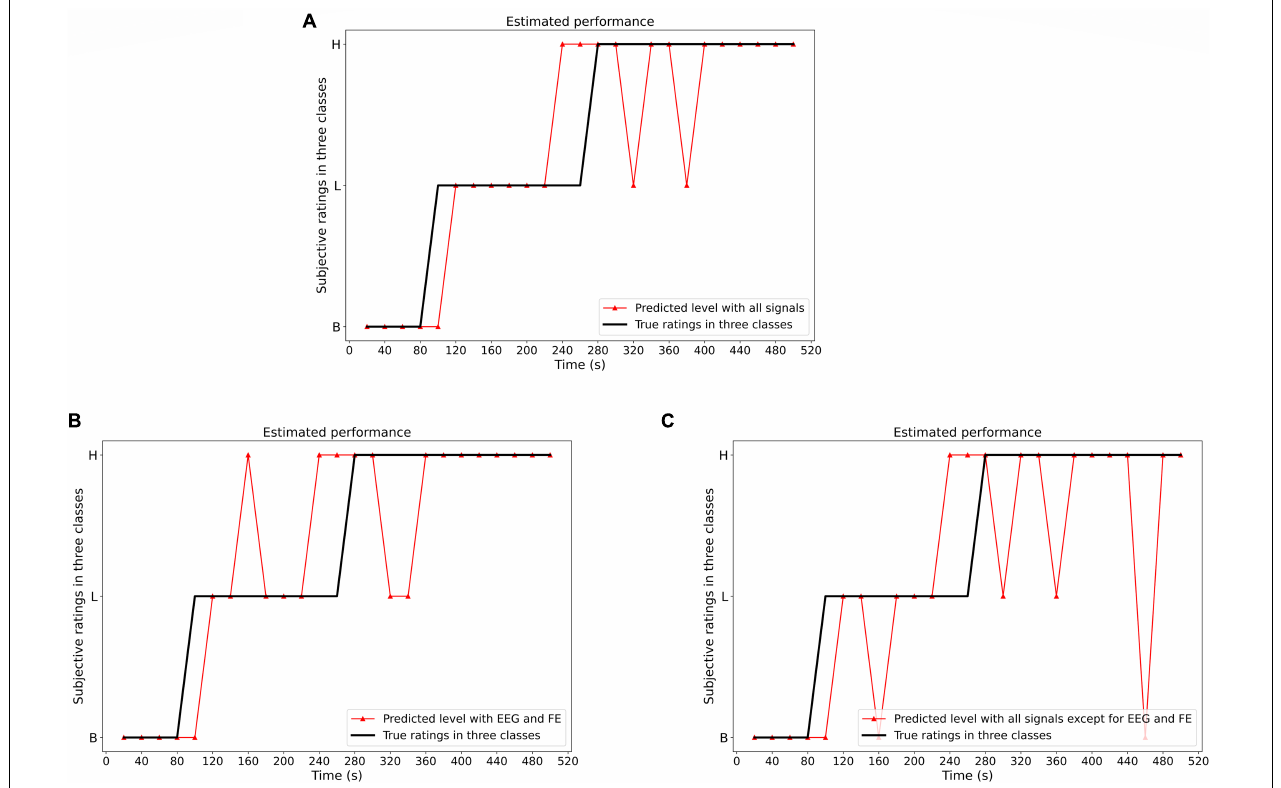
FIGURE 14 | The classification result using different sets of modalities (set 1: all signals; set 2: only EEG and FE; set 3: all signals but EEG and FE). The estimated performance with all signals performs better than that without EEG and FE, especially in Baseline and High pain level estimation. The second set with only EEG and FE performs better than that without EEG and FE, especially in High pain level estimation. (A) Set 1: Estimation result (all signals are used, B, baseline; L, low pain; H, high pain). (B) Set 2: Estimation result (only EEG and FE are used, B, baseline; L, low pain; H, high pain). (C) Set 3: Estimation result (all signals are used except EEG and FE. B, baseline; L, low pain; H, high